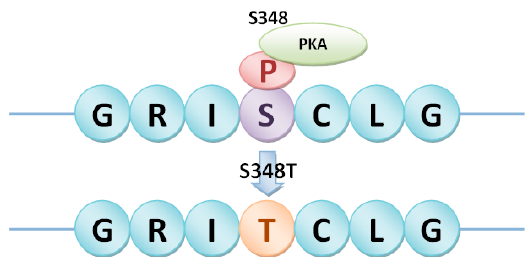
Figure 4. Type I ( − ) phosSNP, S348T, in heterotrimeric G β subunit (LOC_Os03g46650), which removed the protein phosphorylation site S348. PKA: Protein kinase A.